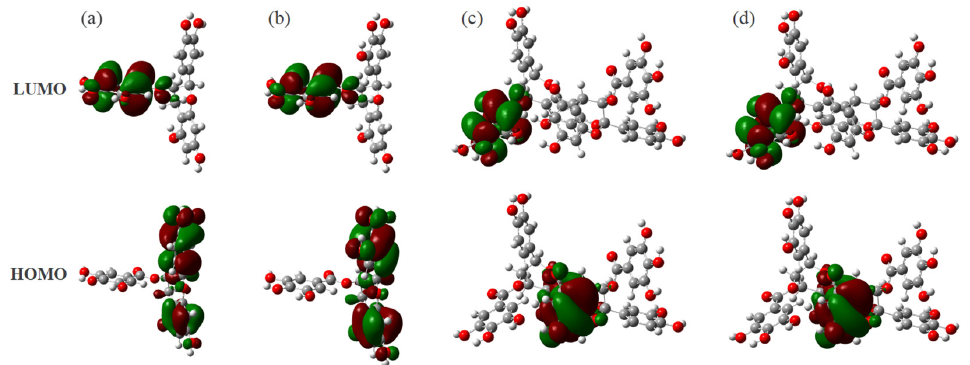
Figure 3. The frontier molecular orbital structure of the four characteristic structural units from PT: ( a ) ECG, ( b ) EGCG, ( c ) A − ECG dimer, ( d ) A − EGCG dimer. ( a ) ECG, ( b ) EGCG, ( c ) A − ECG dimer, ( d ) A − EGCG